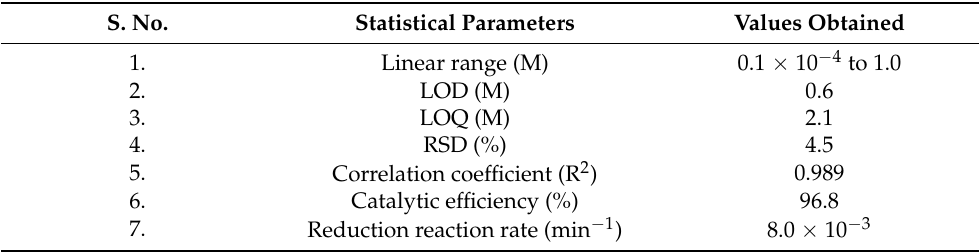
Table 1. DRS-FTIR spectroscopic approach for 4-nitrophenol reduction catalyzed by CR-AgNCs in aqueous solution.